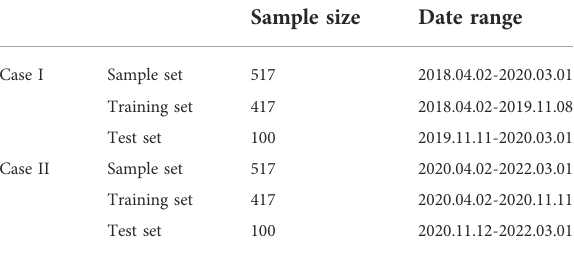
TABLE 1 The size and date range of the